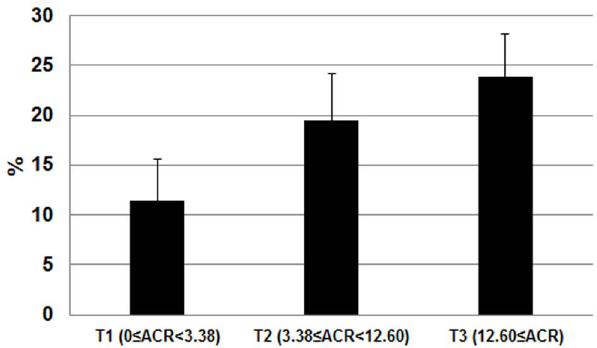
Figure 1. Prevalence of subjects (%) with high intraocular pressure (IOP; $ 18 mmHg) separated by albumin/creatinine ratio (ACR) tertiles (P for trend =0.020).